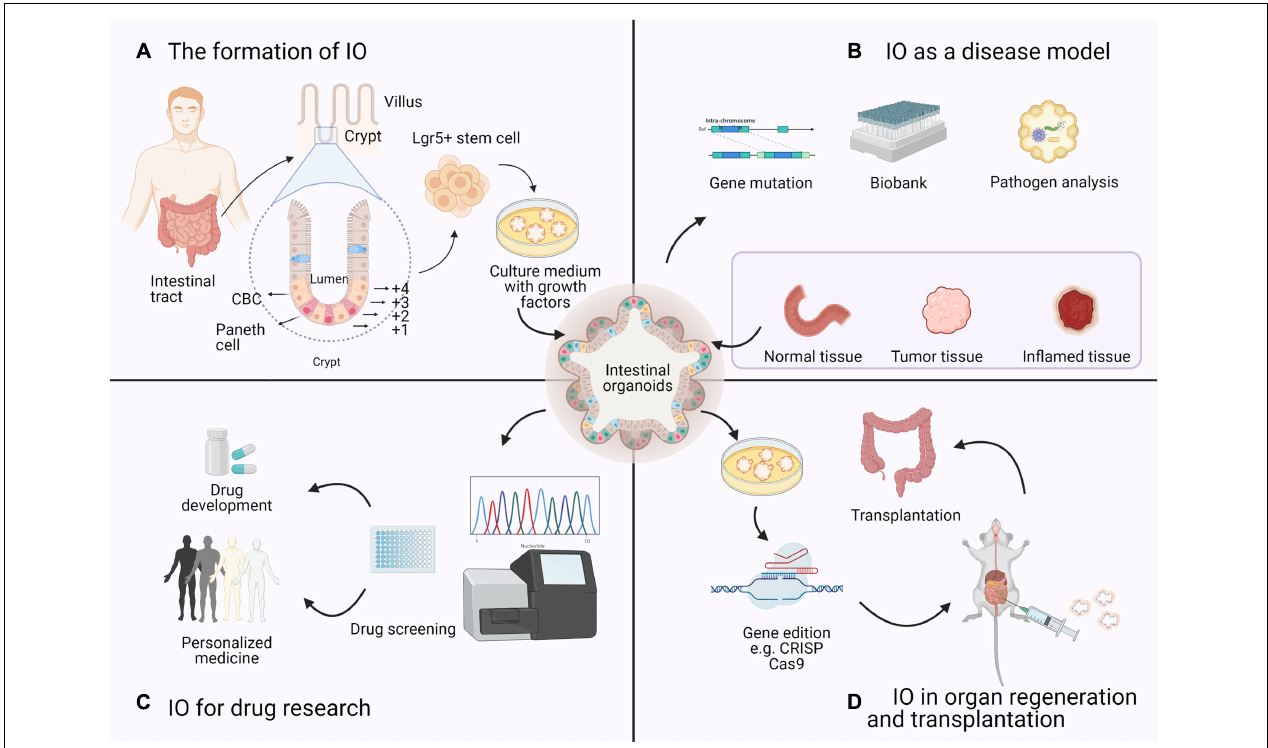
FIGURE 3 | Four research topics on the application of IOs based on bibliometrics. (A) The formation of IO: Organoids are derived from a single Lgr5 + ISC. ISCs reside either at the crypt base, between Paneth cells, as CBCs, or at position +4 from the bottom of the crypt. (B) IO as a disease model: Intestinal diseased organoids use samples from biopsies or resection and preserved as a biobank in basic research. (C) IO for drug research: Based on the sequencing results and gene–drug association links, high-throughput drug screening of candidate drugs can be performed in IOs to determine effective therapeutic strategies. (D) IO in organ regeneration and transplantation: Many studies of organoid transplantation and maturation are in progress, which means that organoids can be used as a source of cells or tissues with genetic mutations for regenerative medicine